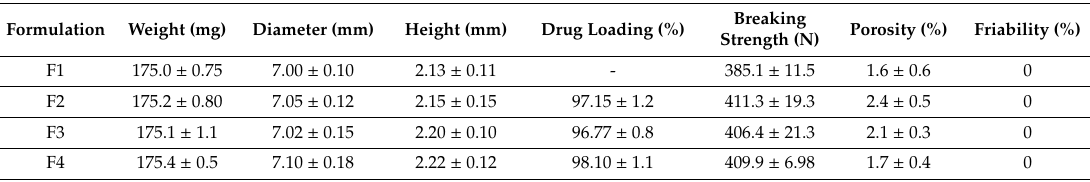
Table 2. Geometrical and drug loading properties of 3D printed